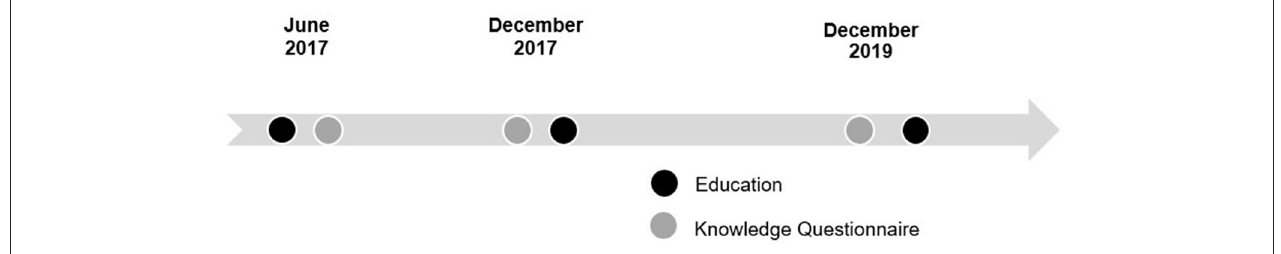
FIGURE 1 | Timeline of education and local staff knowledge